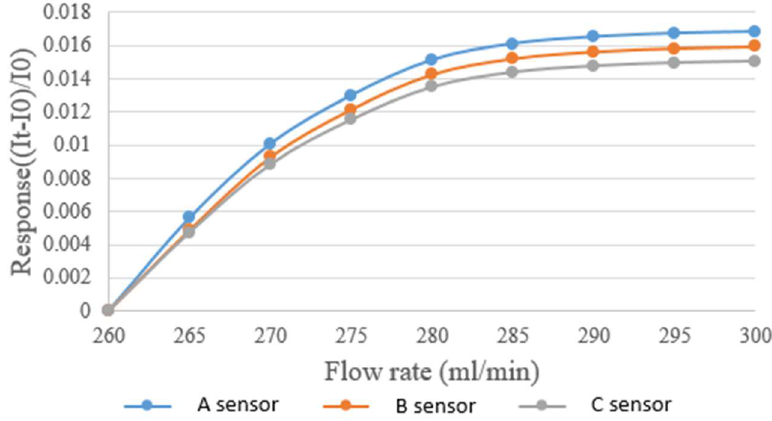
Figure 5. Correction curve of the micro flow sensor.